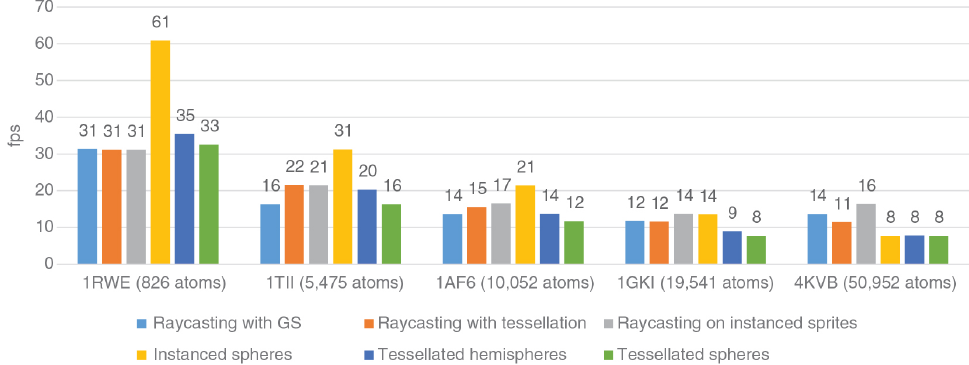
Figure 5: Average frame rates during a full rotation around the data set at 2 m